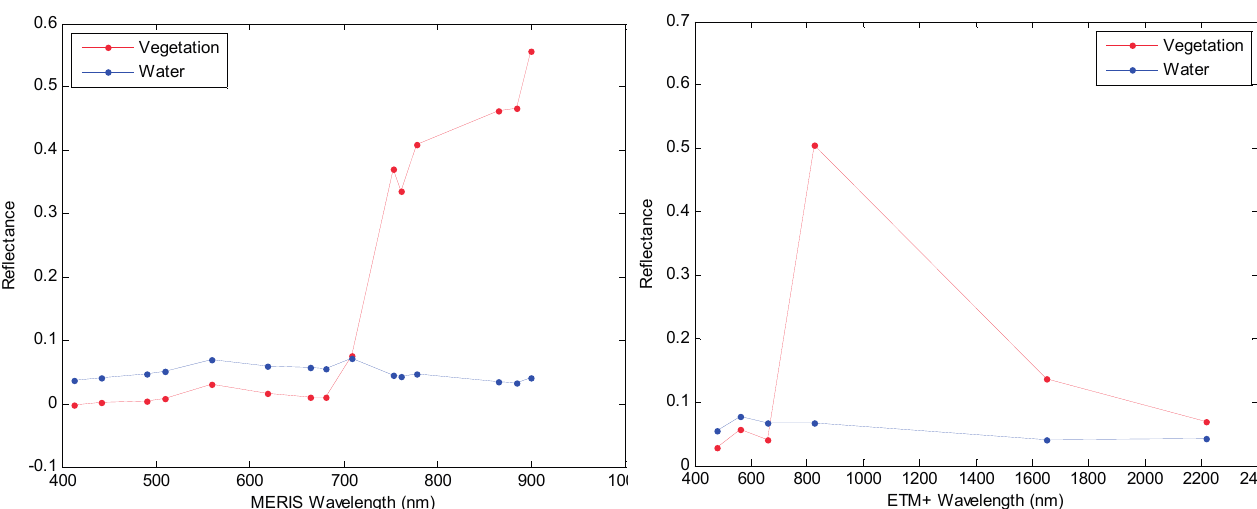
Figure 4. The MERIS endmember spectral library ( left ) and ETM+ endmember spectral library ( right ) used in